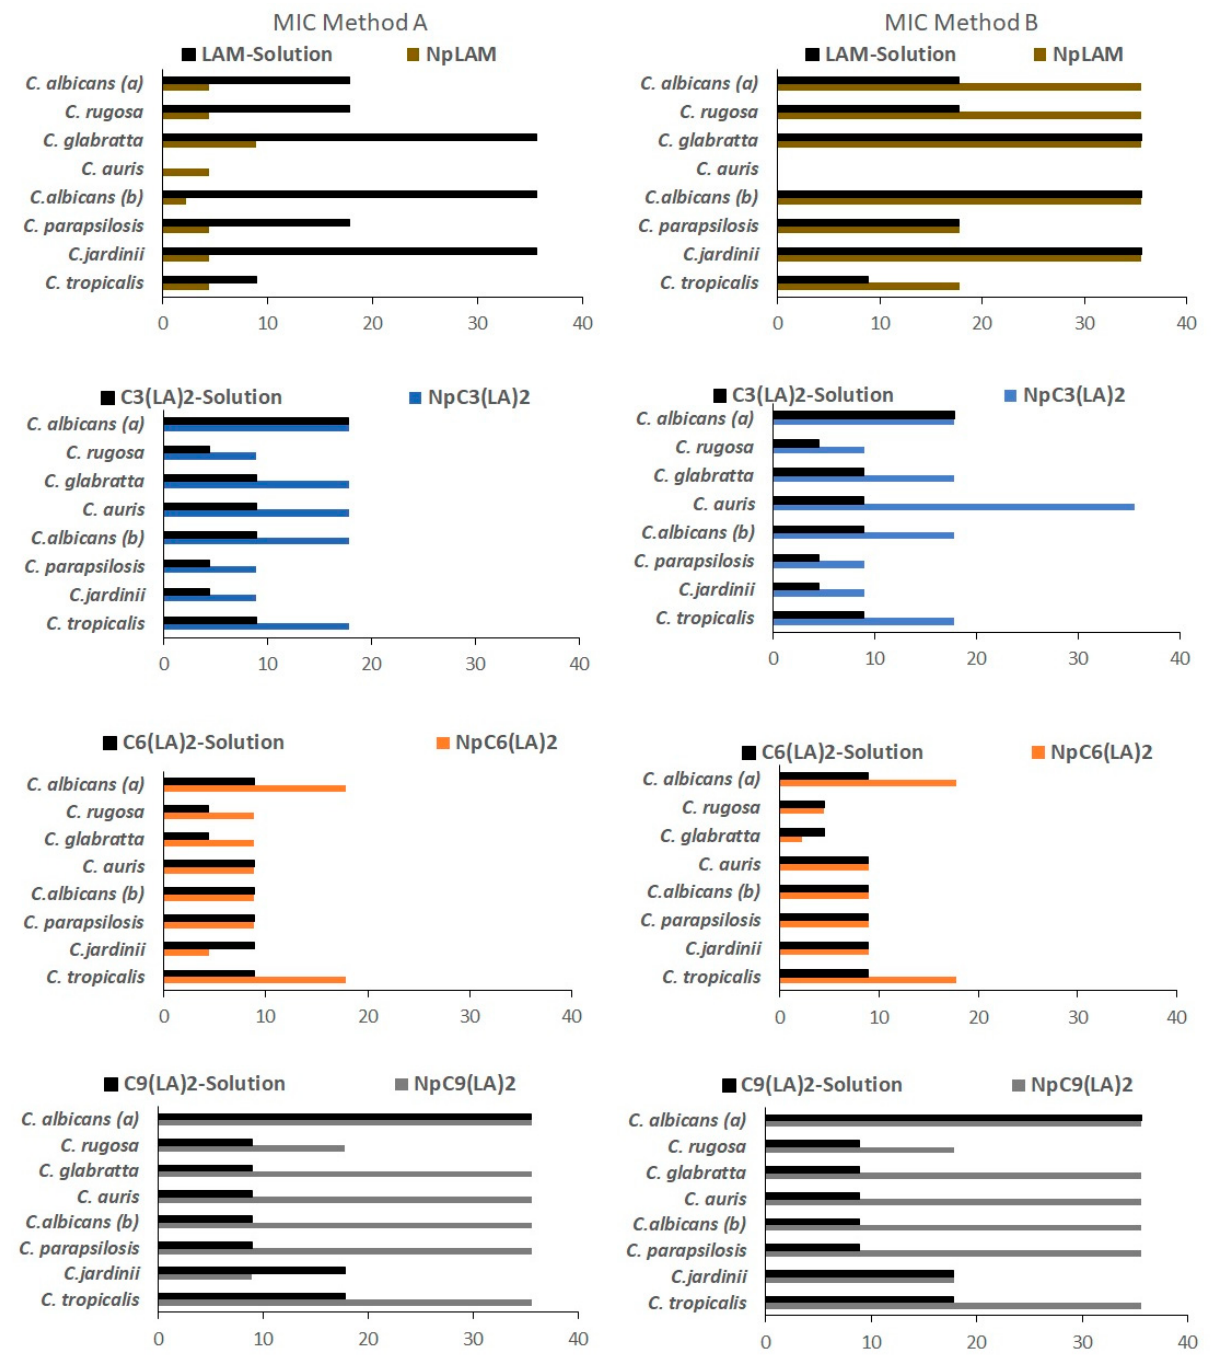
Figure 16. Determination of the MIC ( µ g/mL) for LAM, C 3 (LA) 2 , C 6 (LA) 2 , C 9 (LA) 2 solutions and loaded zein nanoparticles prepared by methods A and B against yeasts. Candida albicans ATCC 10,231 (a) and Candida albicans ATCC 90,028 (b).